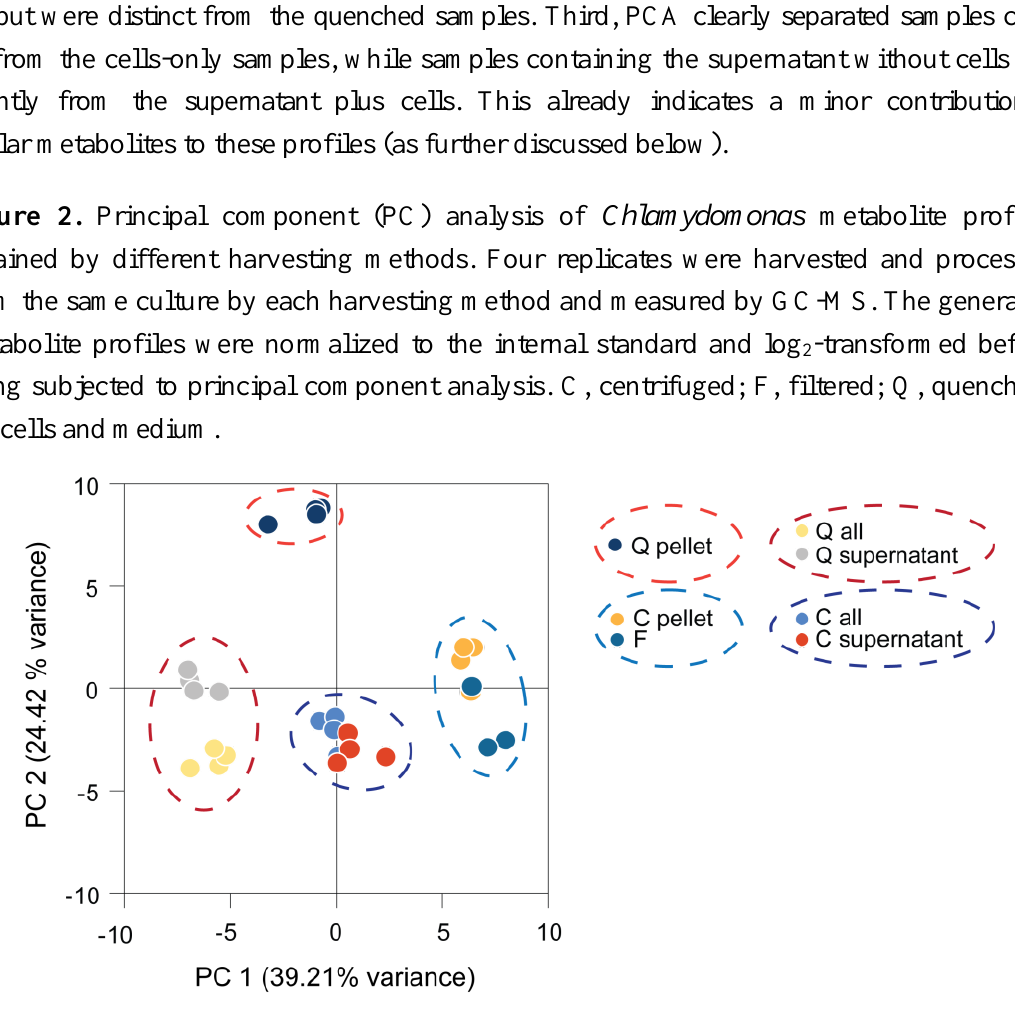
-transformed before 2